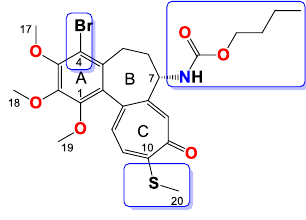
Figure 11. Structure of compound 11 .